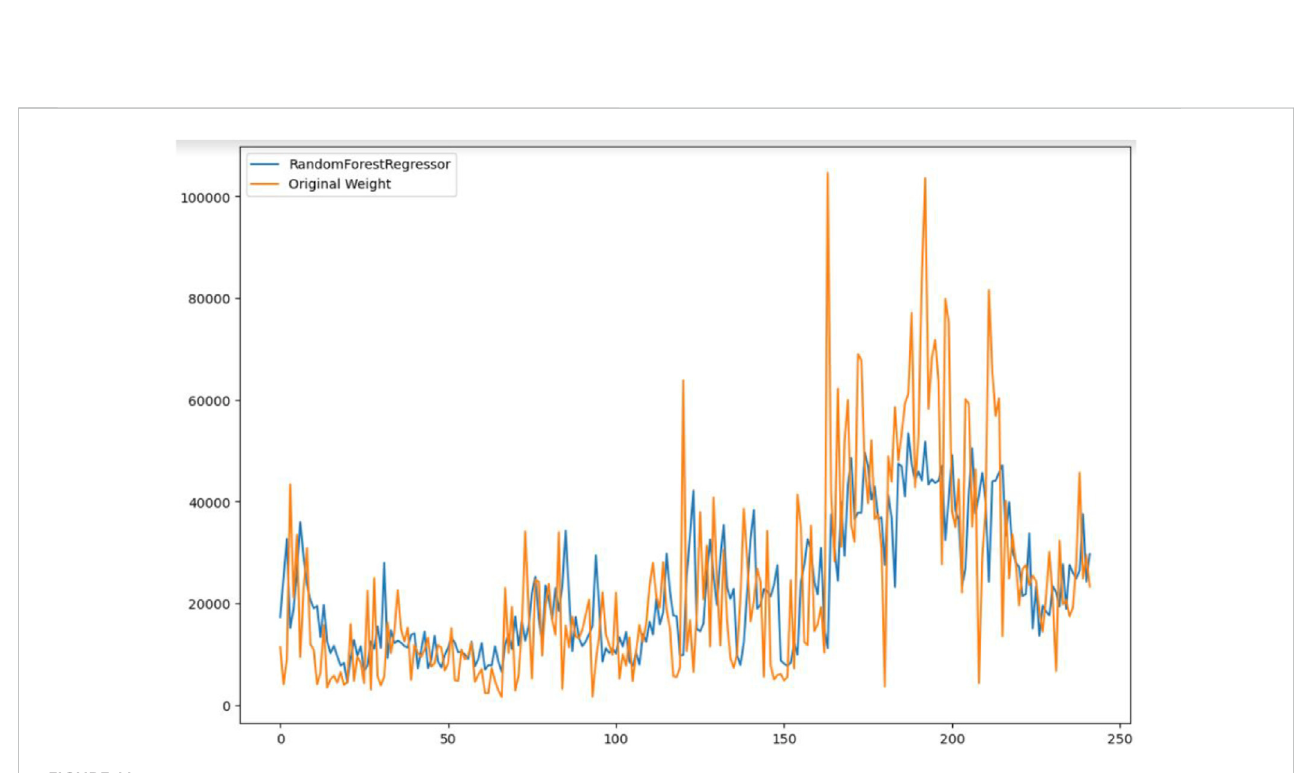
FIGURE 11 Random Forest regression algorithm for prediction of beach waste